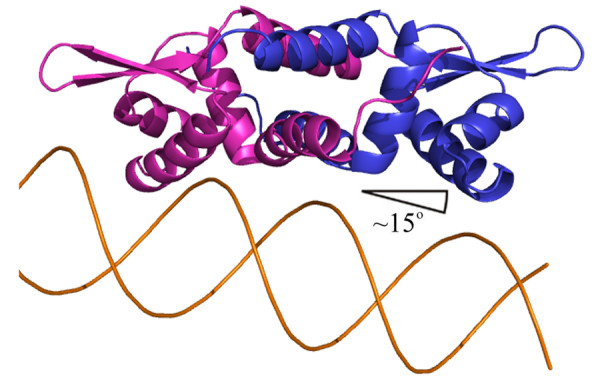
Model of Vc-HlyU binding to DNA based on the similarity of Vc-HlyU with OhrR DNA-recognition motif. Monomers A and B are in magenta and blue color respectively.